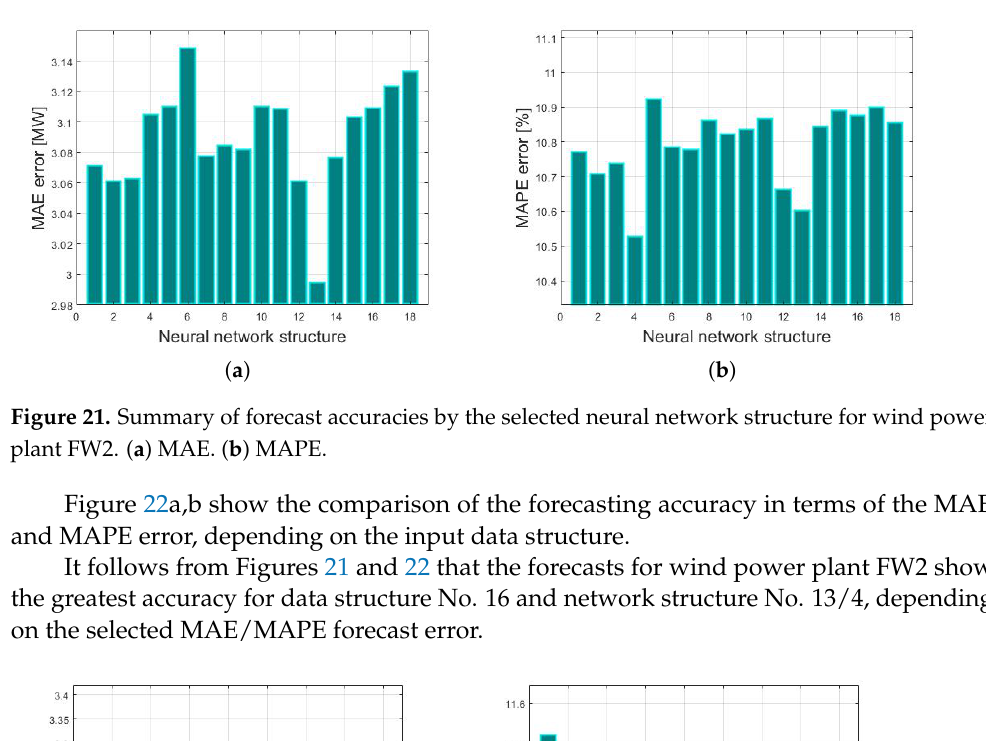
on the neural network structure is shown in Figure 21.